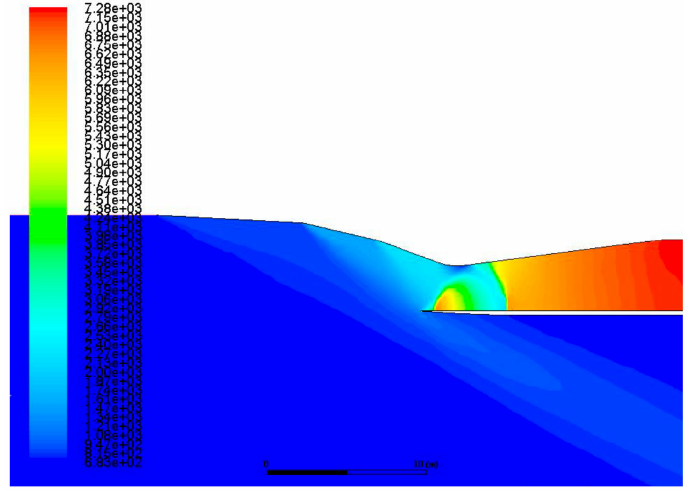
Figure 5. Mach 2.5 static pressure (Pa).